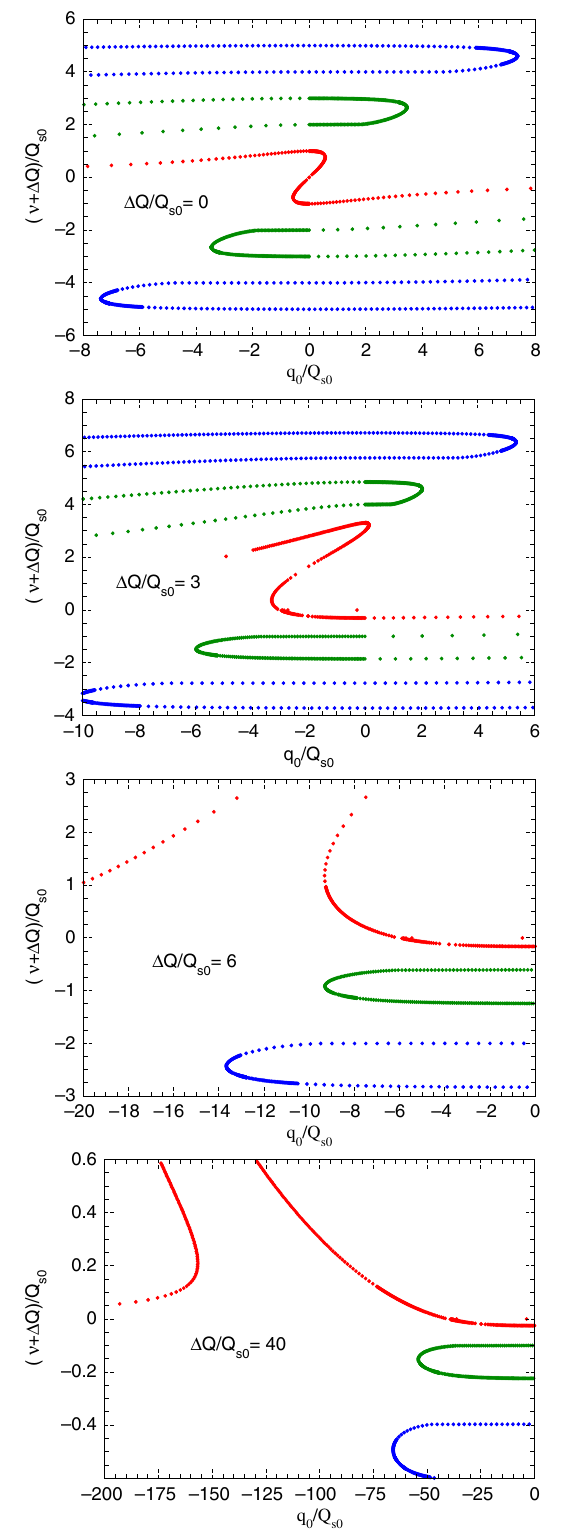
FIG. 5. The bunch head-tail modes against the wake strength at different SC tune shifts. The extremal points where dq 0 ¼ 0 mark the beginning of the instability region. Only negative wakes are ≥ 6 displayed at Δ Q=Q s 0